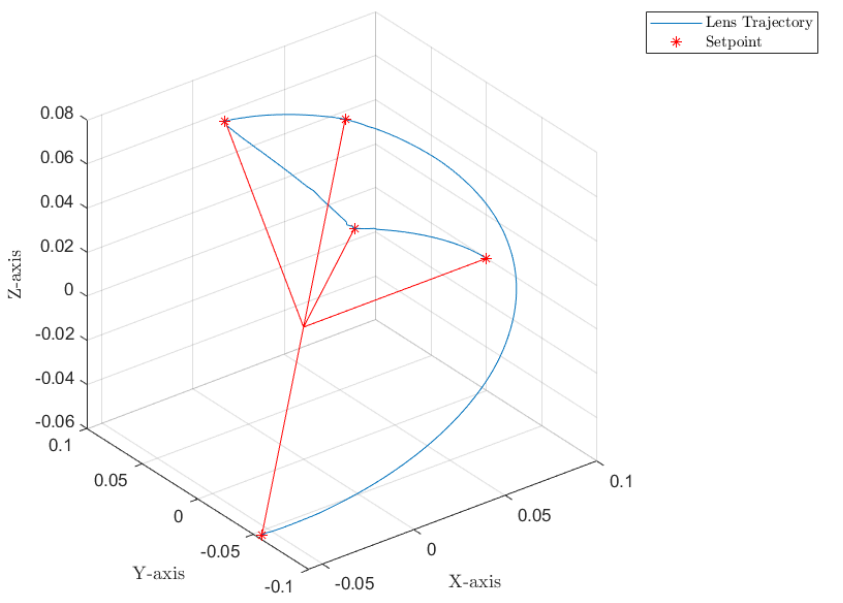
Figure 20. Combined trajectories of Links 1 and 2 to form the camera path in R 3 Cartesian coordinates.